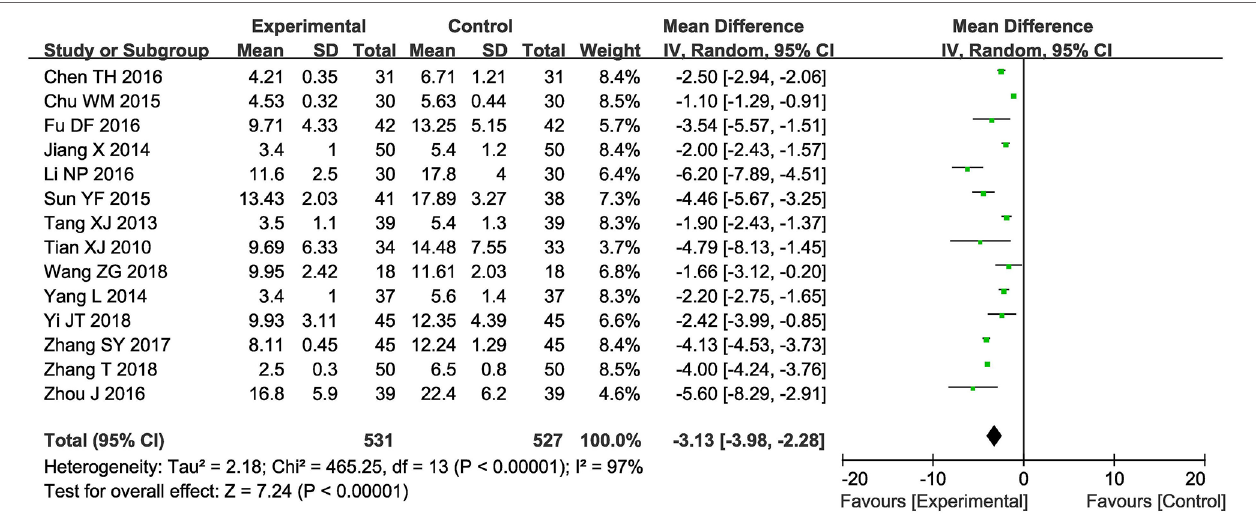
FIGURE 4 | Forest plot of the comparison of National Institutes of Health Stroke Scale (NIHSS) between the experimental and control group. Control group, conventional treatments alone group; Experimental group, conventional treatments and GDI combined group. GDI, Ginkgo leaf extract and dipyridamole injection. The random effects meta-analysis model (Inverse Variance method) was used.